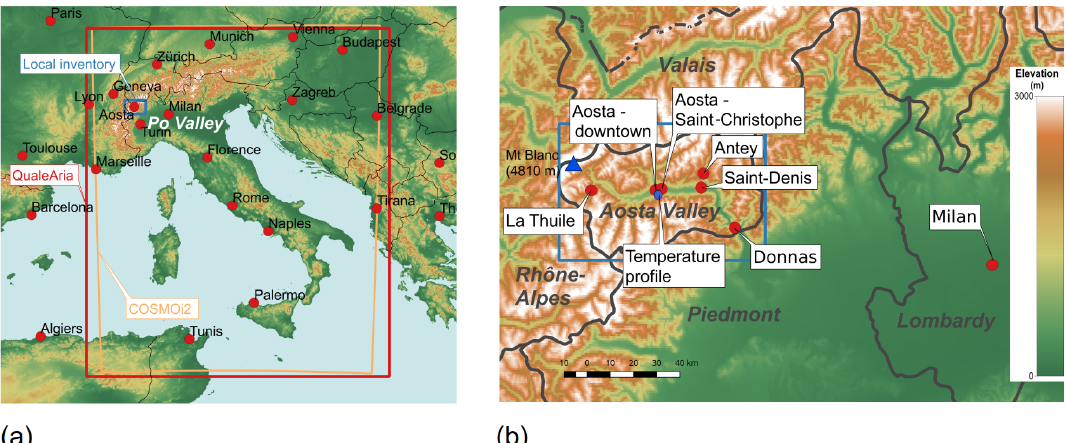
Figure 2. (a) Elevation map of Italy, showing the position of the investigated Alpine region and the geographical domains of (1) the numerical weather prediction model (COSMO-I2, orange box), (2) the national emission inventory (QualeAria, red box), and (3) the local inventory of the Aosta Valley (blue box). (b) Zoom over the Aosta Valley and northwestern Italy, with location of the measurement stations. The blue box corresponds to the geographic domain of the local inventory as in panel (a) . The elevation (colour) scale is the same for both